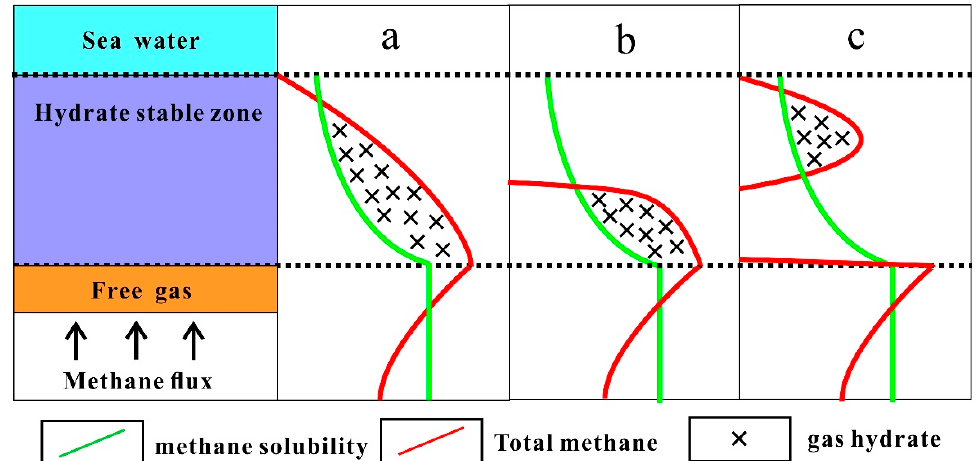
Figure 9. Hydrate formation mechanism under different gas migration conditions (with a high methane flux from the bottom)